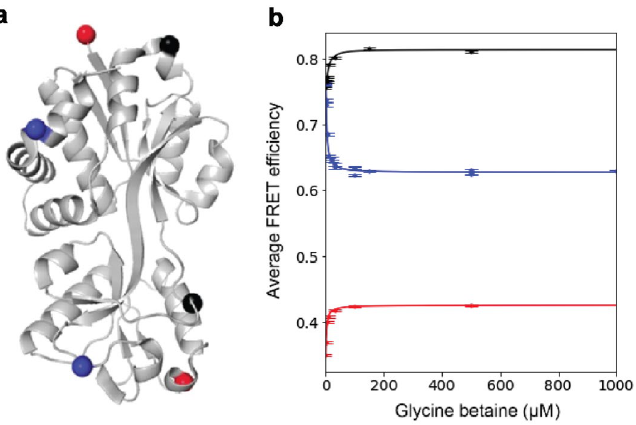
Figure 3. The three newly selected SBD mutation pairs that were constructed for OpuAC. ( a ) Structural representation (PDB:3L6G); red: (D320C/K453C), black: (T504C/K521C) and blue: (N414C/K566C). ( b ) FRET change upon binding of glycine betaine in the FRET pairs depicted in panel ( a ); the color coding is the same as in the structure; error bars represent the standard deviation obtained from the Gaussian fit in the smFRET data analysis.